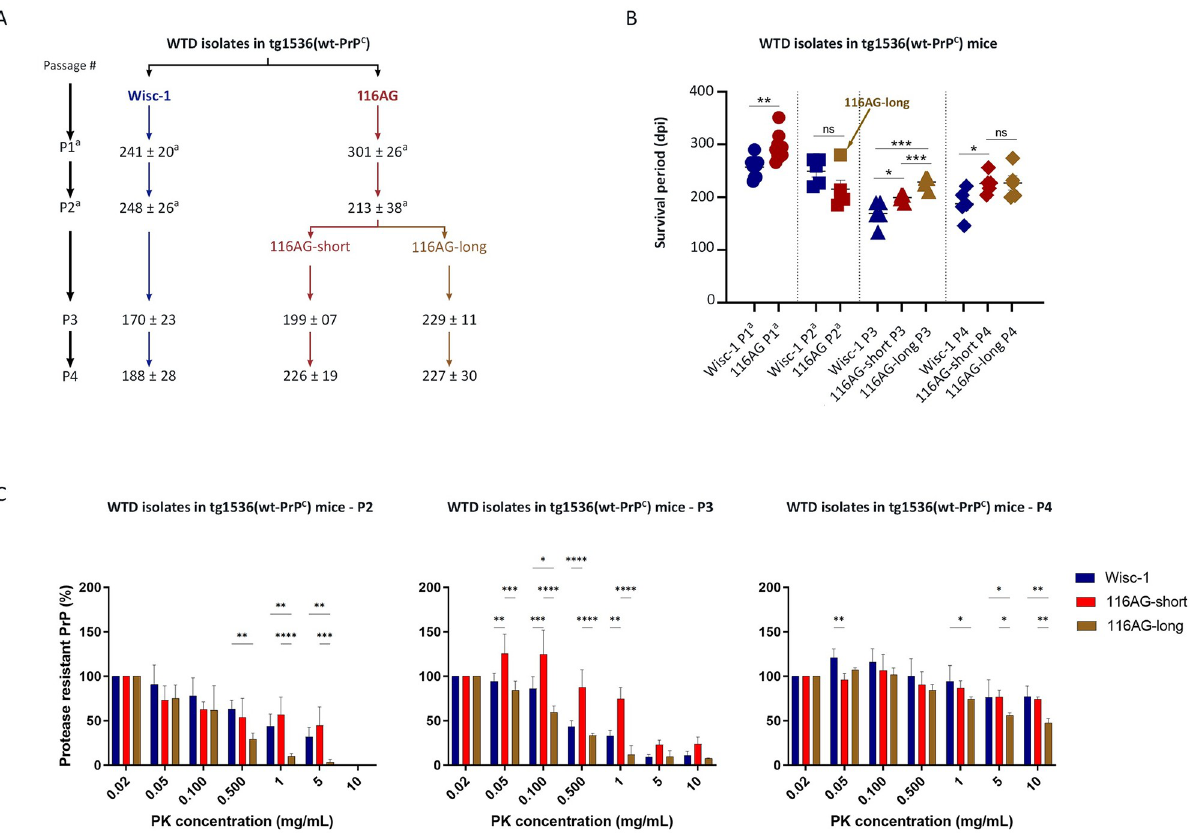
Fig 1. Serial transmission of Wisc-1 and 116AG isolates in tg1536 +/+ mice. Tg1536 +/+ mice, overexpressing wt deer PrP 6 to 8fold, were inoculated intracerebrally with 20ul of 1% (w/v) brain homogenate. (A) Scheme of the serial transmission (1 st ➔ 4 th passage) of Wisc-1 and 116AG isolates to tg1536 +/+ mice, mean survival times with standard deviation are shown. (B) Representative graph of the survival times of tg1536 +/+ mice inoculated with Wisc-1 or 116AG prions. The y-axis represents the survival period (dpi) and the x-axis the different passages. Wisc-1 inoculated mice are represented by blue shapes and 116AG inoculated mice are represented by red shapes (filled for 116AG-short and open for 116AG-long). � p < 0.05, �� p < 0.01, ��� p < 0.001, and ns p > 0.05; unpaired student’s t-test was used to compare between different groups of mice. (C) Resistance to PK was assessed using different concentrations of PK to digest brain homogenates of WTD passaged isolates in tg1536 mice (P2, P3 and P4 represent second, third and fourth passage). The PrP res signal was quantified by densitometric and blotted into graphs using GraphPad Prism software for analyses. � P < 0.05, �� P < 0.01, ��� P < 0.001 and ���� P < 0.0001 refers to differences between PK resistance of Wisc-1 (blue bars), 116AG-short (red bars) and 116AG-long (brown bars). Statistical analyses were performed using two-way ANOVA followed by post hoc (Tukey’s multiple comparisons test; GraphPad Prism software). a data from Hannaoui et al.